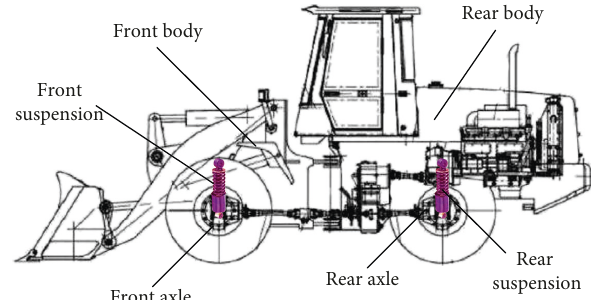
Figure 1: Structure of the wheel loader with axle suspension.